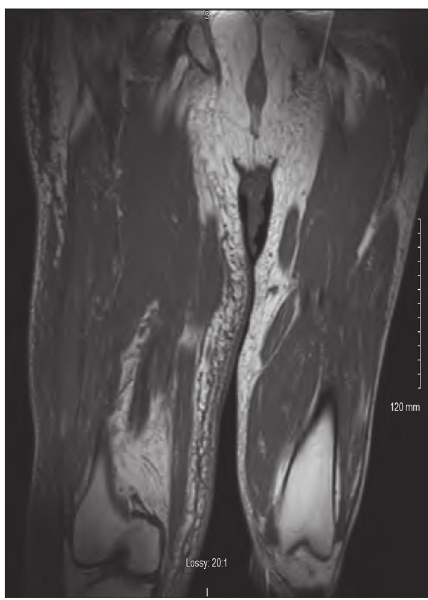
Figure 2: MRI without contrast of the right femur: bilateral in- flammatory changes manifested by extensive subcutaneous edema with interfascial free fluid as well as severe myositis. Dispropor- tionate enlargement of the right vastus medialis muscle which is diffusely heterogeneous with a patchy area of intramuscular hemorrhage is